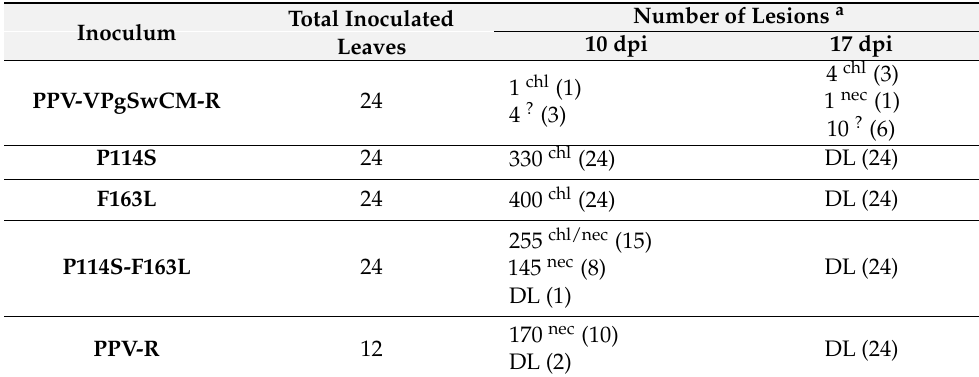
Table 1. Effect of VPg mutations on the infection of the PPV-VPgSwCM-R chimera in Chenopodium